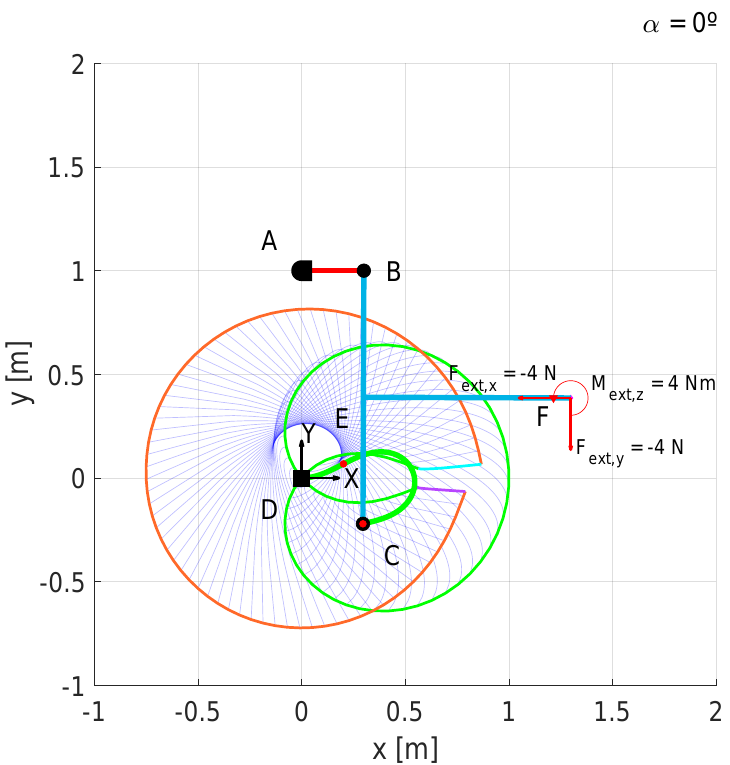
Figure 19. Second mechanism circuit under external loading of F ext , x = − 4 N, F ext , y = − 4 N, and M ext , z = 4 Nm. Initial position.